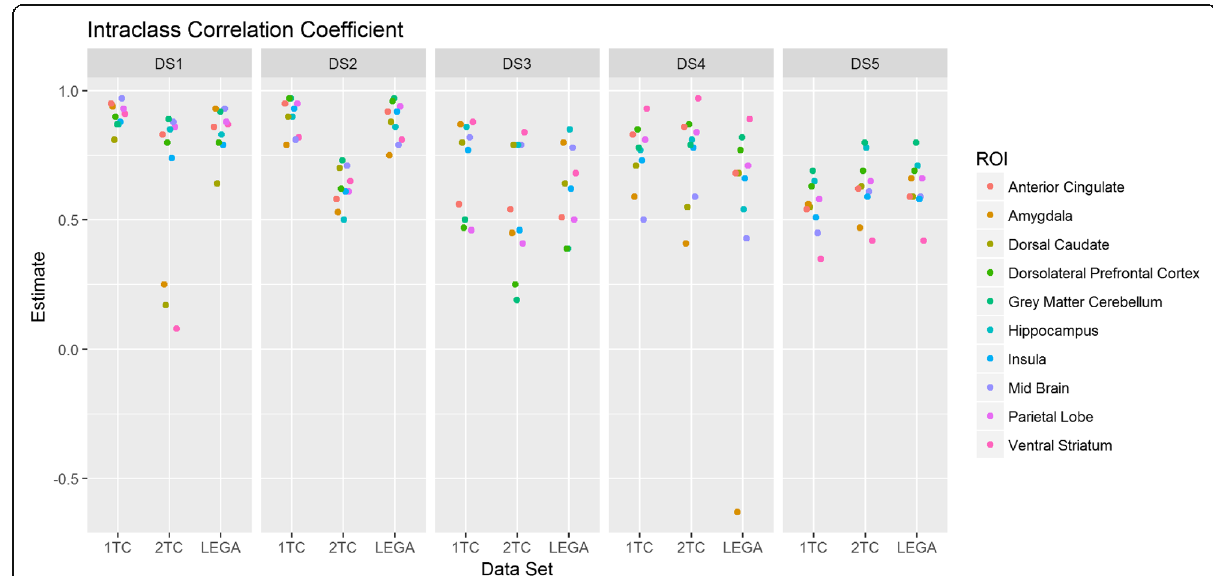
Fig. 2 Intraclass correlation coefficient (ICC) across the considered datasets. Each point in the plot, for a given dataset, represents a particular region of interest (ROI) so that the plot represents the variability of ICC across the considered ROIs. For each data set, DS1, DS2, DS3, DS4, and DS5, there were three quantification methods investigated (1, 2, and L denote one-tissue compartment model, two-tissue compartment model, and likelihood estimation in graphical analysis,